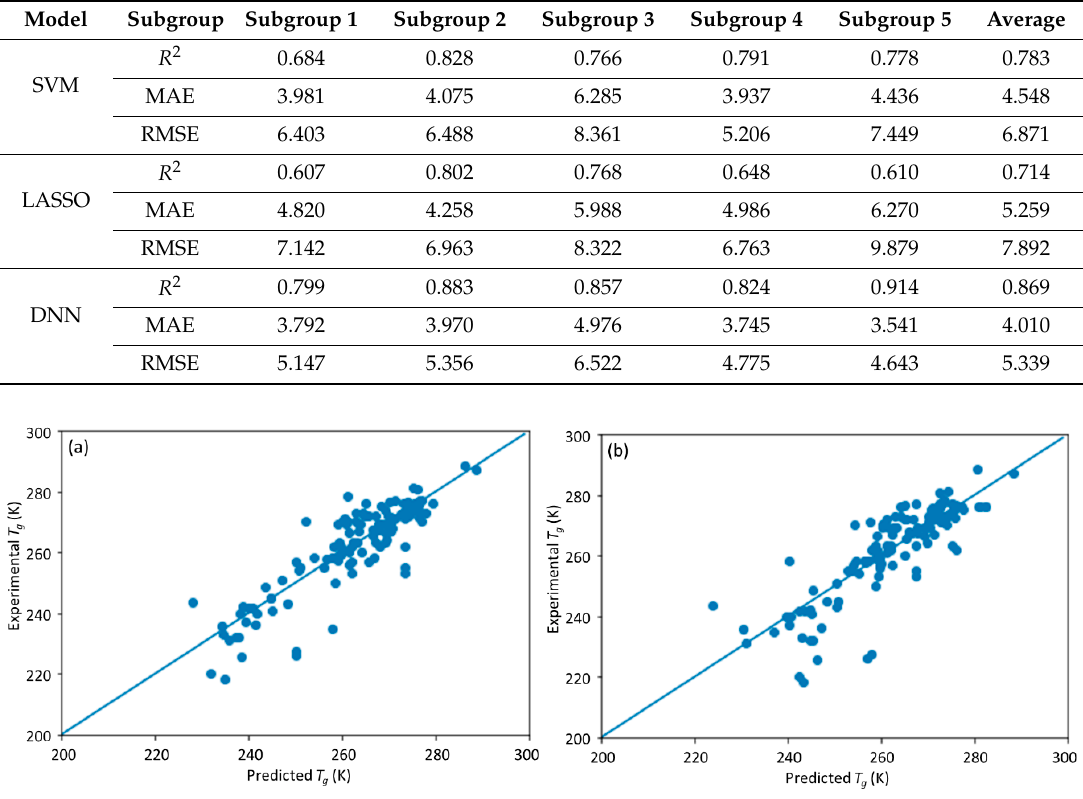
Figure 7. The predicted vs. experimental T g using ( a ) SVM and ( b ) LASSO (results by DNN are shown in Figure 5).